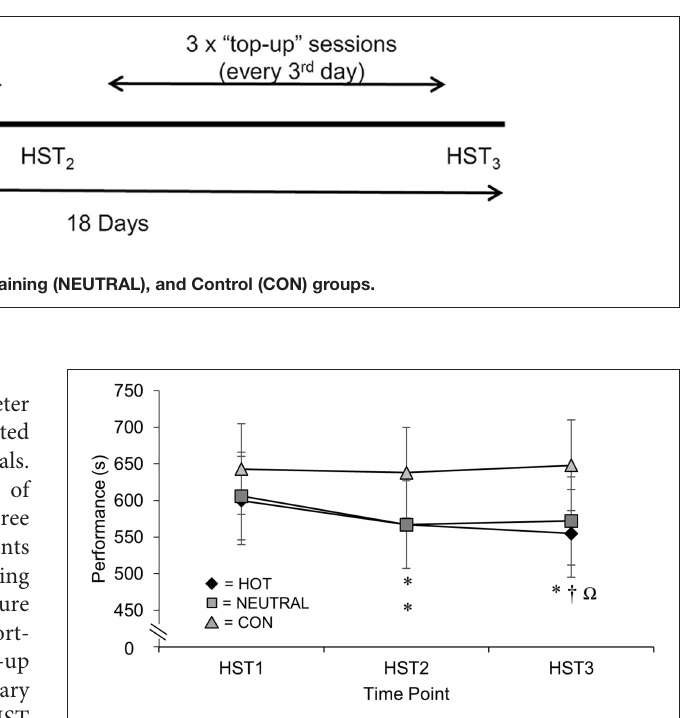
FIGURE 2 | Adjusted means ± SD of 5km time trial performance (s) across heat stress tests (HST) 1, 2, and 3 for Heat